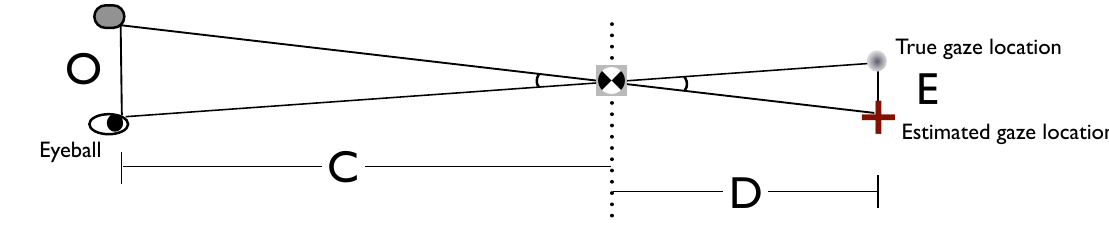
Figure 9. Calculating parallax error. The amount of parallax error (E) for a mobile eye-tracker can be calculated for any distance from the calibration plane (D), when the distance between the calibration plane and the observer (C) and size of the offset between the scene camera and eyeball (O) are known. Geometrically, E/D = O/C, and therefore E = OD/C. This formula holds regardless of whether gaze is being calculated at distances beyond the calibrated plane, or at distances between the observer and the calibrated